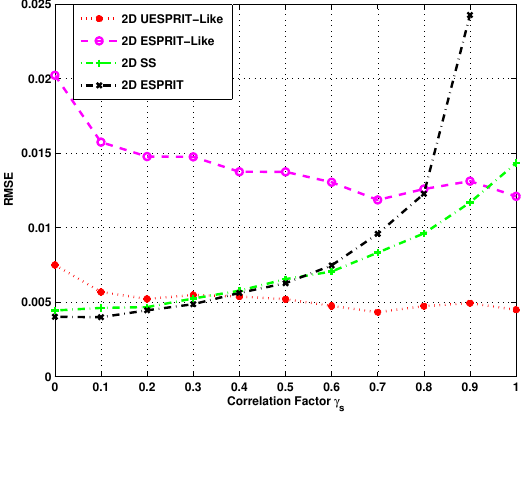
Figure 6. RMSE of the DOA estimates versus correlation